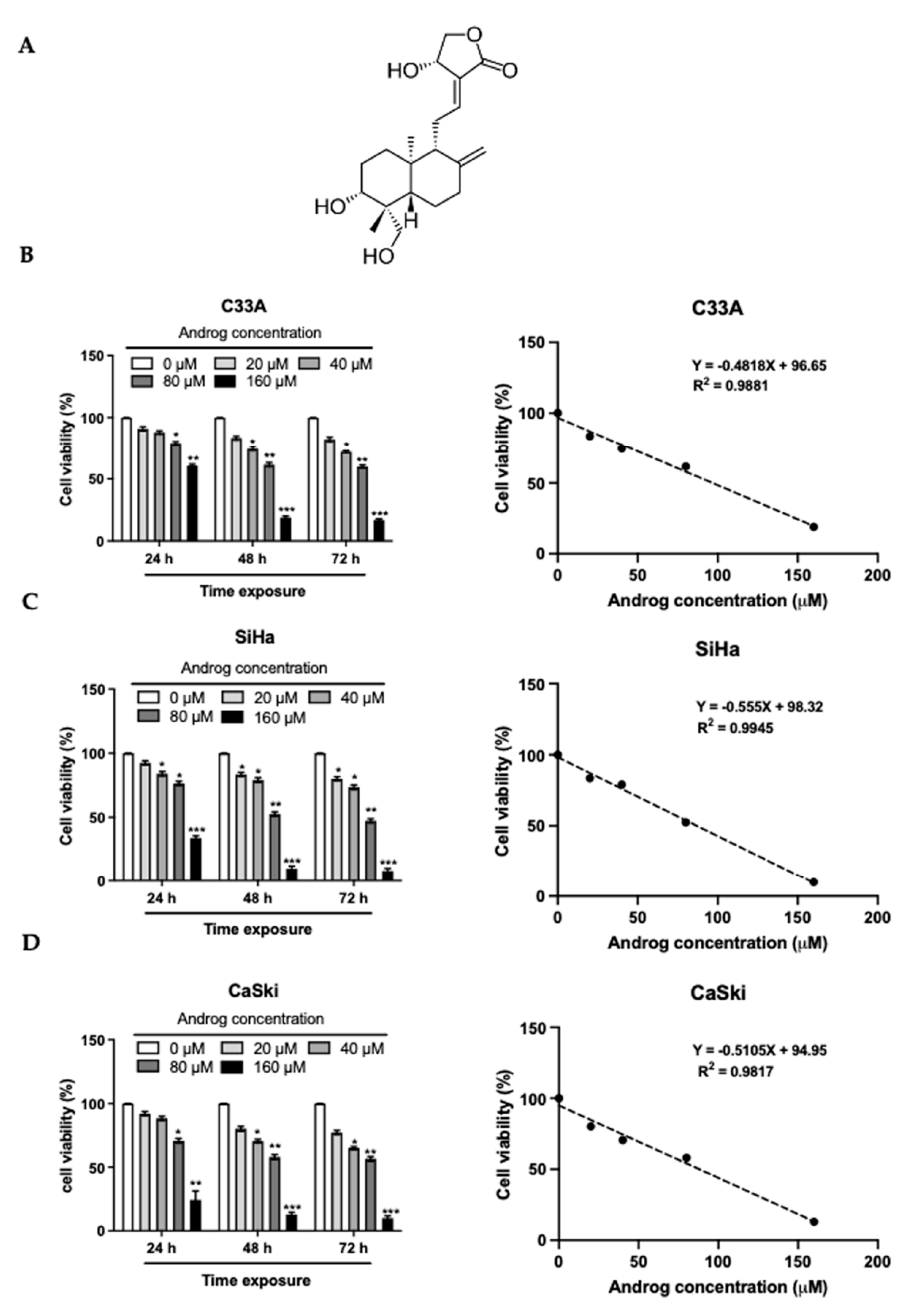
Figure 1. Survival of cervical cancer cell lines after treatment with Androg. ( A ) Chemical structure of Androg. ( B–D ) Measurement of Androg’s cytotoxicity on cervical cancer cell lines in time- and dose-dependent manner ( right panel = 48-h exposure ) including, C33A ( B ), SiHa ( C ), and CaSki ( D ), using an MTT assay. * p < 0.05 ** p < 0.01 *** p < 0.001.